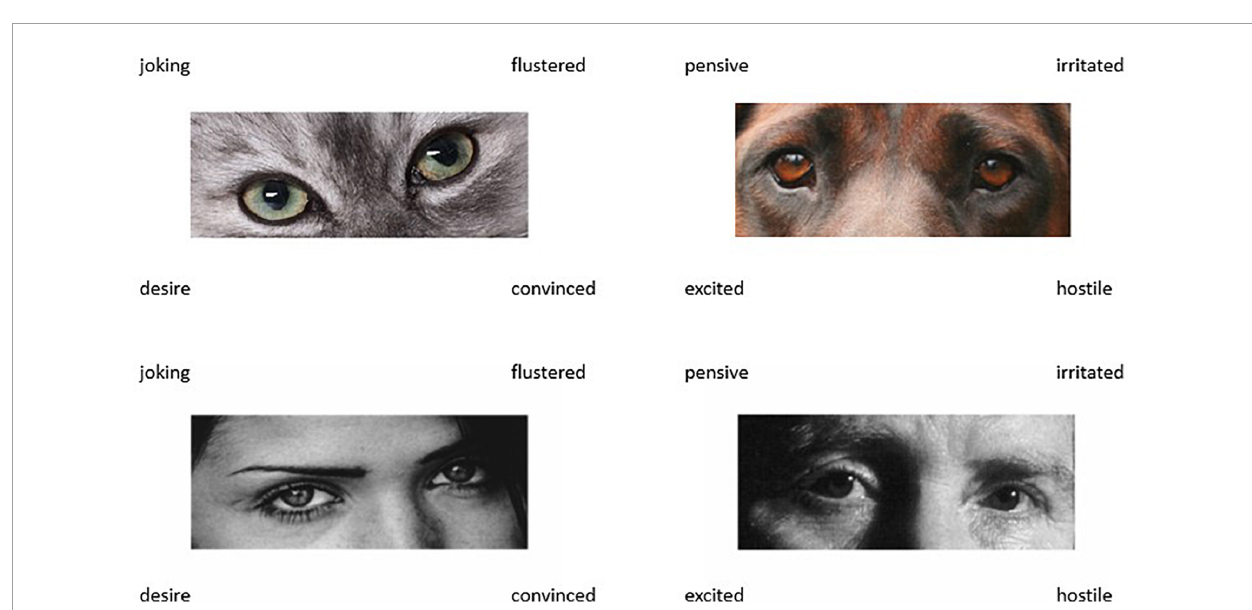
FIGURE2 Example trials from the NARMET (upper) as compared to the RMET. Images were available without reuse restrictions. NARMET images adapted from https://pxhere.com/en/photo/979960, animals.com/animals/bavarian-mountain-hound/pictures/, and RMET images from